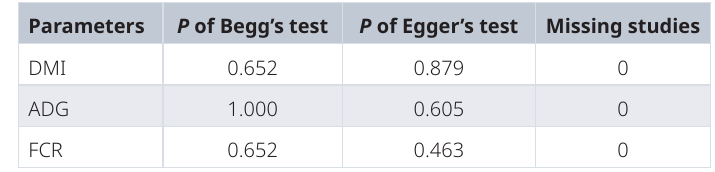
Table 4. Summary of publication bias analysis of the effect of dietary essential oil intervention on growth response of small